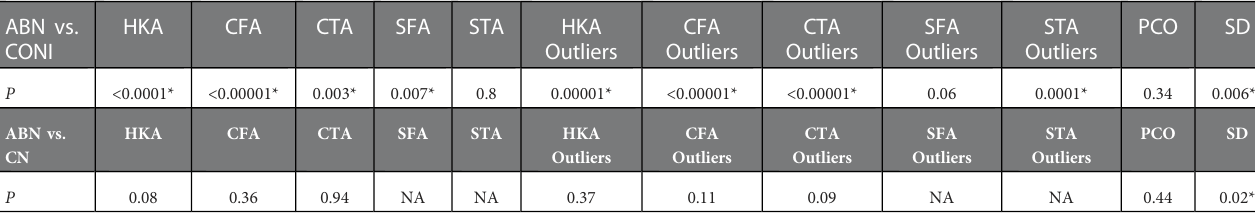
TABLE 3 Calculated P values for study outcomes. ABN vs.